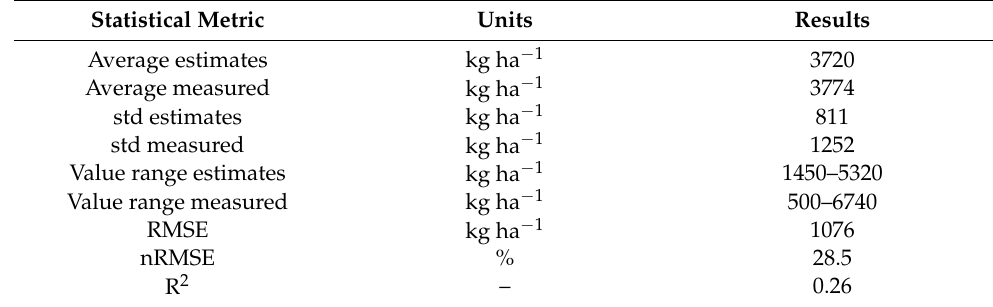
Table 3. Statistical evaluation of the transfer function (n =